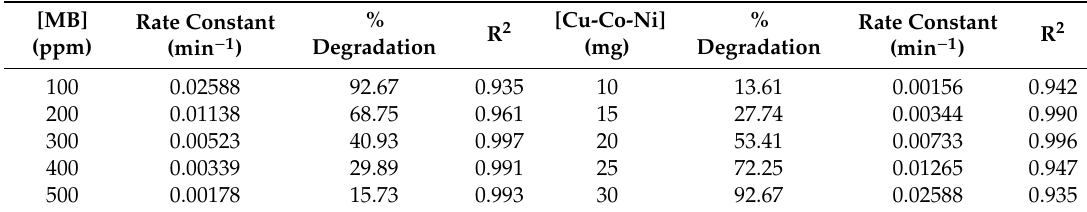
Figure 10. ( a ) The plot of ln(C t /C o ) vs. time (min) as a function of initial MB dye concentration on the degradation efficiency, ( b ) plot of ln(Ct/C o ) vs. time (min) as a function of photocatalyst dosages on the degradation of MB. Table 1. Rate constants, % degradation of MB dye, and correlation coefficients (R 2 ) of the MB photocatalytic degradation.